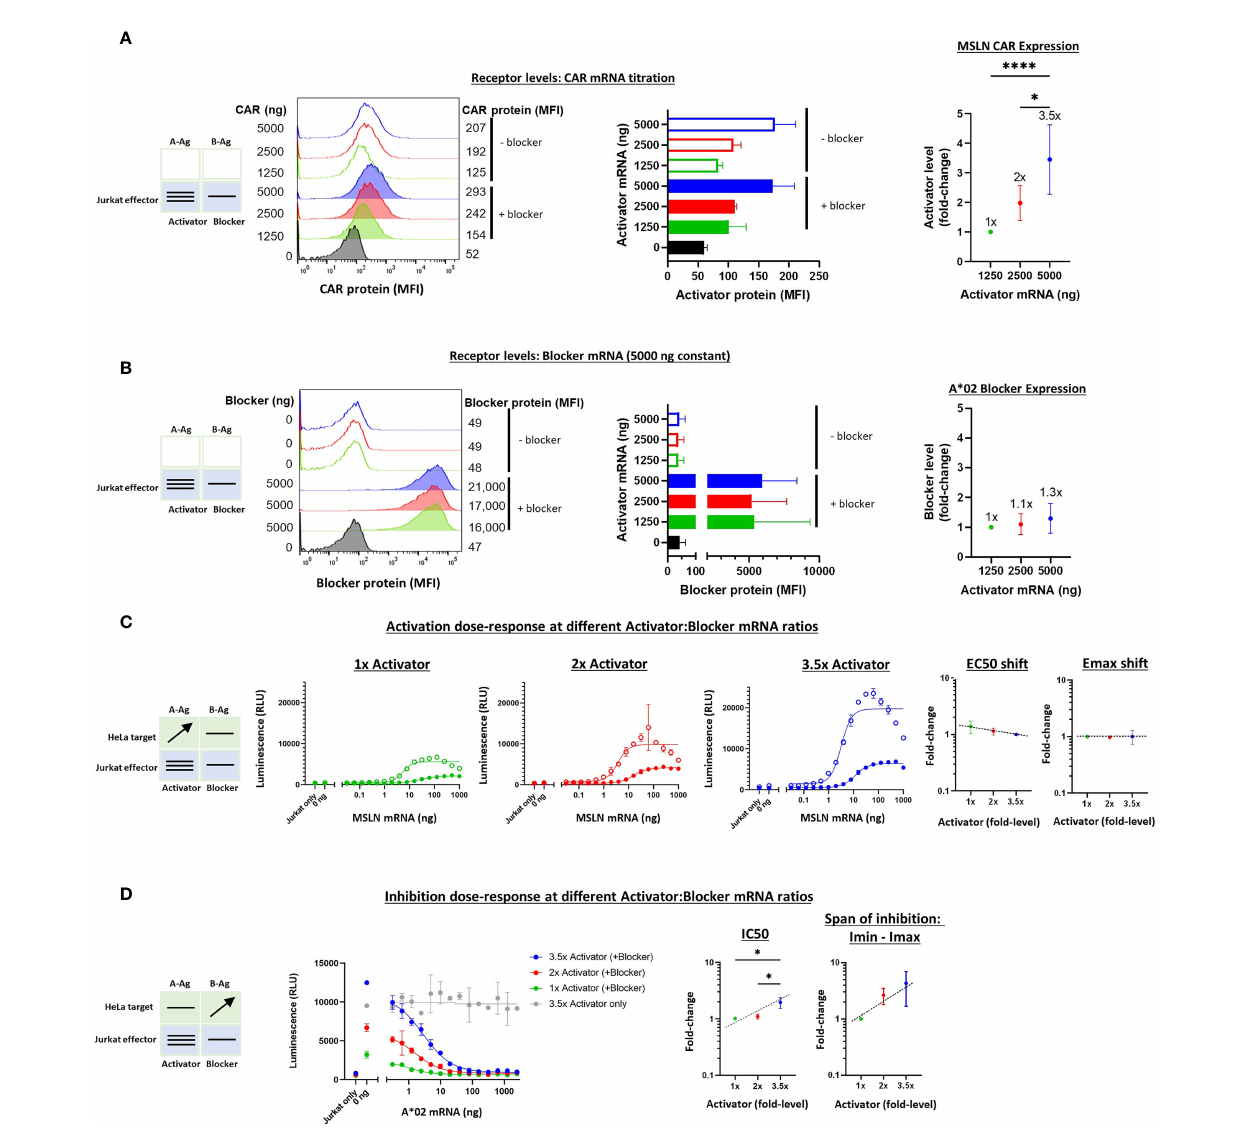
FIGURE 5 | Altering the ratio of MSLN CAR activator to A*02 blocker in effector cells. Cell surface staining of activator and blocker receptors vs. various MSLN CAR mRNA amounts, analyzed by fl ow cytometry. Blocker was held constant at 5000 ng mRNA and activator (MSLN CAR) was varied at 0, 1250, 2500 and 5000 ng as shown. (A) MSLN CAR and A*02 blocker. MSLN CAR was stained with labeled MSLN tetramer (see Methods ). To calculate fold-expression, background was subtracted before normalization to the lowest value. Bar chart colors match fl ow histogram colors. (B) Blocker protein level is minimally affected by varying activator level. Surface expression of blocker at different mRNA amounts of CAR activator. Blocker was stained with A*02 pMHC tetramer (see Methods ). Fold-changes shown on graphs (i.e. 1x, 2x, 3.5x) are based on surface protein estimates, not mRNA amount. MFI, geometric mean fl uorescence intensity. (C) Activation response to varied ratios of MSLN CAR to A*02 blocker. Open circles = CAR only, fi lled circles = CAR + blocker. Activation dose-response curves are shown for each ratio of CAR to blocker tested. MSLN knockout HeLa cells provided the stimulus. MSLN A-Ag levels were varied with constant B-Ag (2 ng A*02 mRNA, ~3,000 molecules/ cell). Shifting of EC50 and Emax with blocker present is shown for each activator amount. (D) Inhibition response to varied MSLN CAR to A*02 blocker ratios. Wildtype HeLa cells provided the A-Ag stimulus (endogenously expressed ~50,000 MSLN molecules/cell), and B-Ag (A*02 mRNA) was varied. Dashed lines are meant to convey trends and are not fi t mathematically. *p<0.05, **p < 0.01, ***p < 0.001, ****p < 0.0001, n =